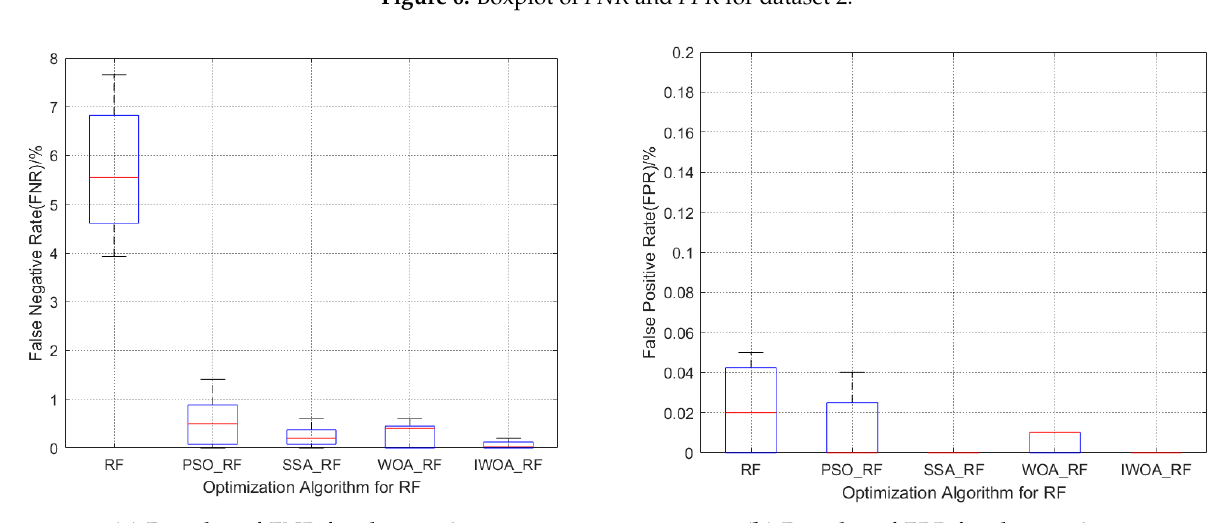
Figure 7. Boxplot of FNR and FPR for dataset 3.